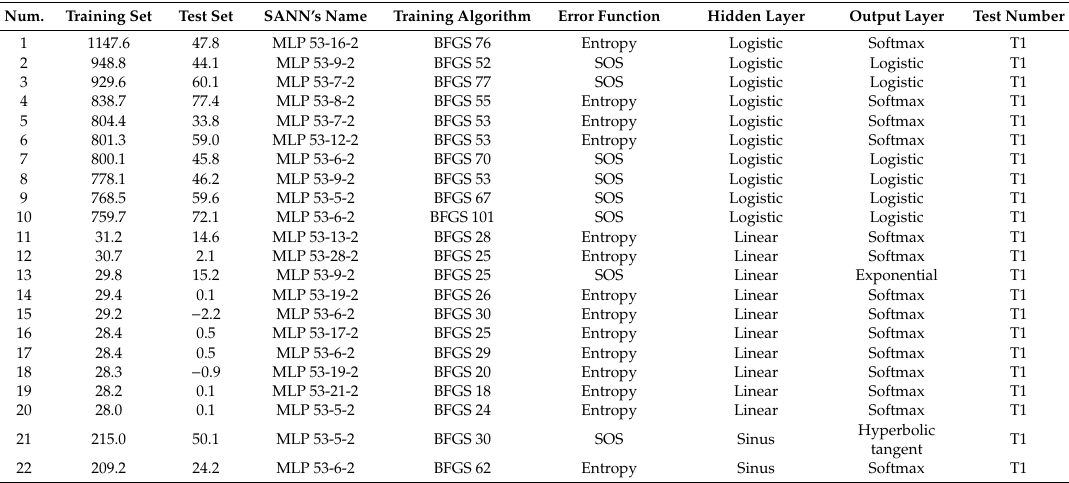
Table A1. Best SANN’s